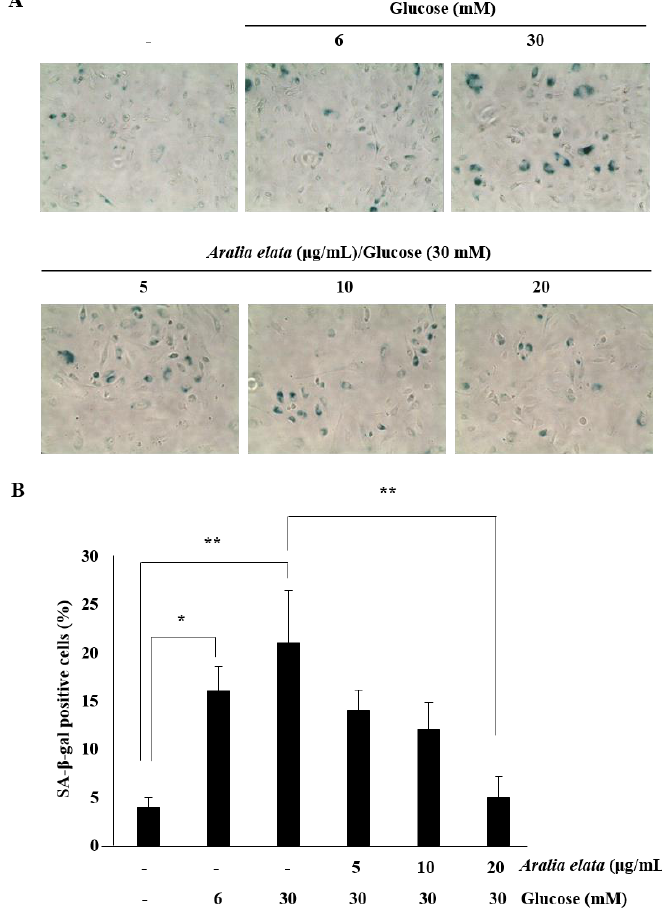
Figure 4. Effects of AS on the senescence of HUVECs cultured with HG medium. ( A ) Representative images of SA- β -gal staining (blue) of HUVECs treated with media alone, media containing HG, or media containing HG and AS (0–20 µ g / mL) for 48 h. ( B ) Percentages of SA- β -gal positive cells in the different groups. SA- β -gal positive cells in treatment groups were calculated as a percentage of those in the control group. * p < 0.05; ** p < 0.01 vs. control group.